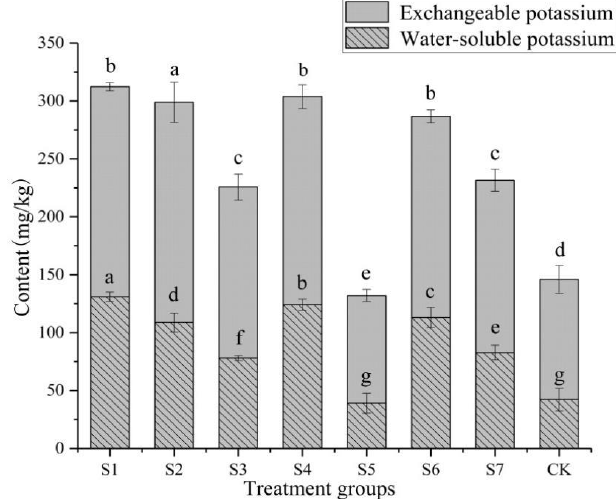
Figure 2. Effects of potassium-solubilizing bacteria on available potassium in rhizosphere soil of Paris polyphylla var. yunnanensis. Data (means ± SE, n = 10) followed by different letters above the bars indicate significant differences between treatments. The same as below.